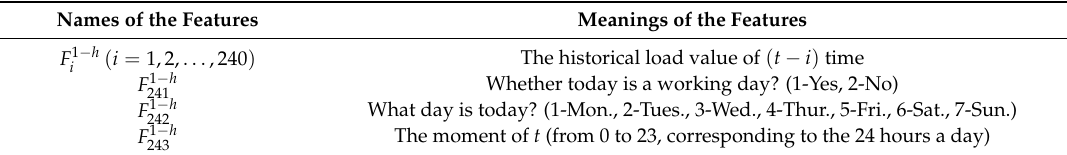
Table 2. The composition of original feature set used for 1-h-ahead prediction.